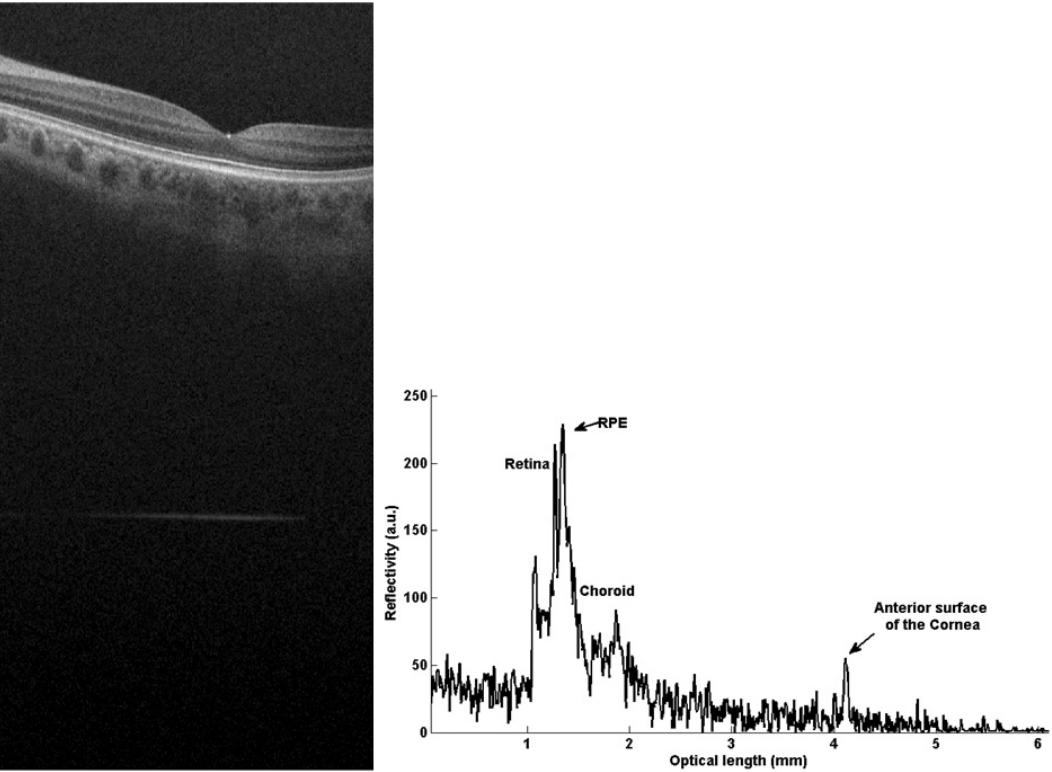
Fig. 2. Composite A-scan of low myopic human eye in vivo . The retina is located close to the origin of the graph and the front surface of the cornea further away. (a) gives the cross section OCT image, which contains the retinal image and corneal signal. (b) is the A-line information for the IOL measurement. For this subject, the AL calculated by the formula is (35 (cid:2) 2.236)/ 1 : 3375 ¼ 24 : 496 mm. For comparison, length measurement data of myopic eyes with IOL master also has been conducted. The comparisons between our SD-OCT system and IOL master results are given in Table